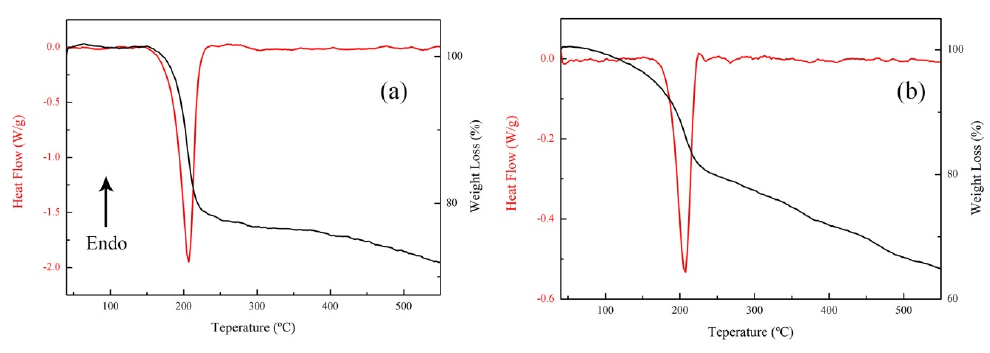
Figure 7. TG-DSC curves of ( a ) nGO-Cu and ( b ) nGO-Fe.